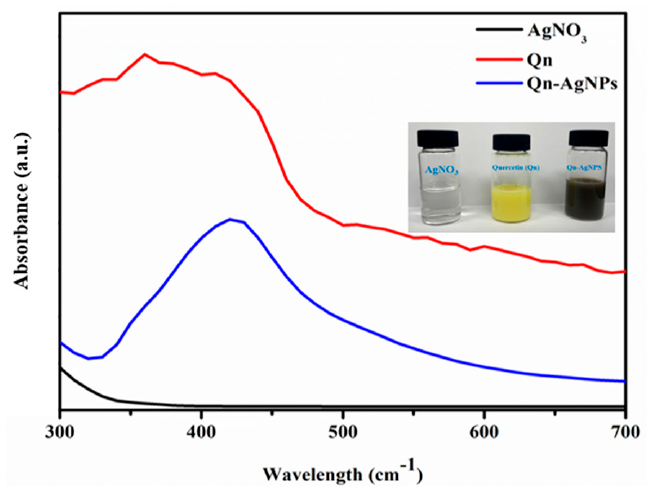
Figure 1 . UV-visible spectrum of silver nitrate (AgNO 3 ), quercetin (Qn) and quercetin mediated synthesized silver nanoparticles (Qn-AgNPs). The inner image shows the color of AgNO 3 , Qn, and Qn-AgNPs in a glass container.